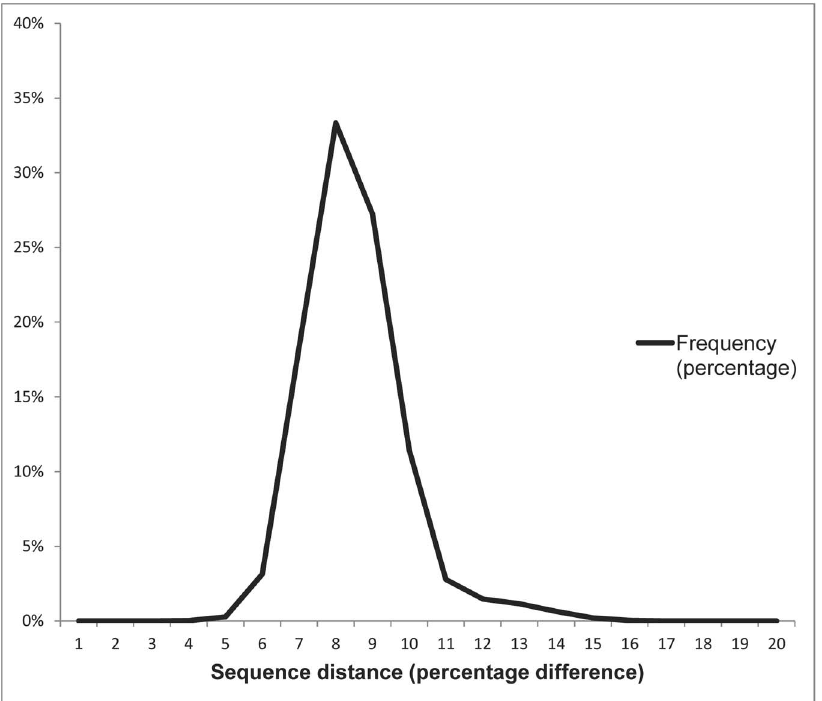
Figure 1. The distribution of uncorrected genetic distance between sequences of different patients. The median uncorrected genetic distance for sequences from different patients was 7.4% (95% range: 5.4% to 11.1%).